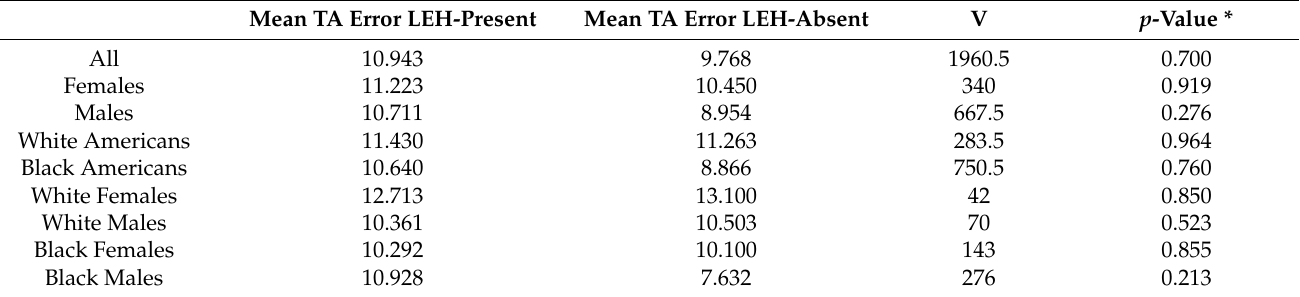
Table 3. Results of Wilcoxon’s tests comparing absolute TA error (in years) for groups with and without LEH.